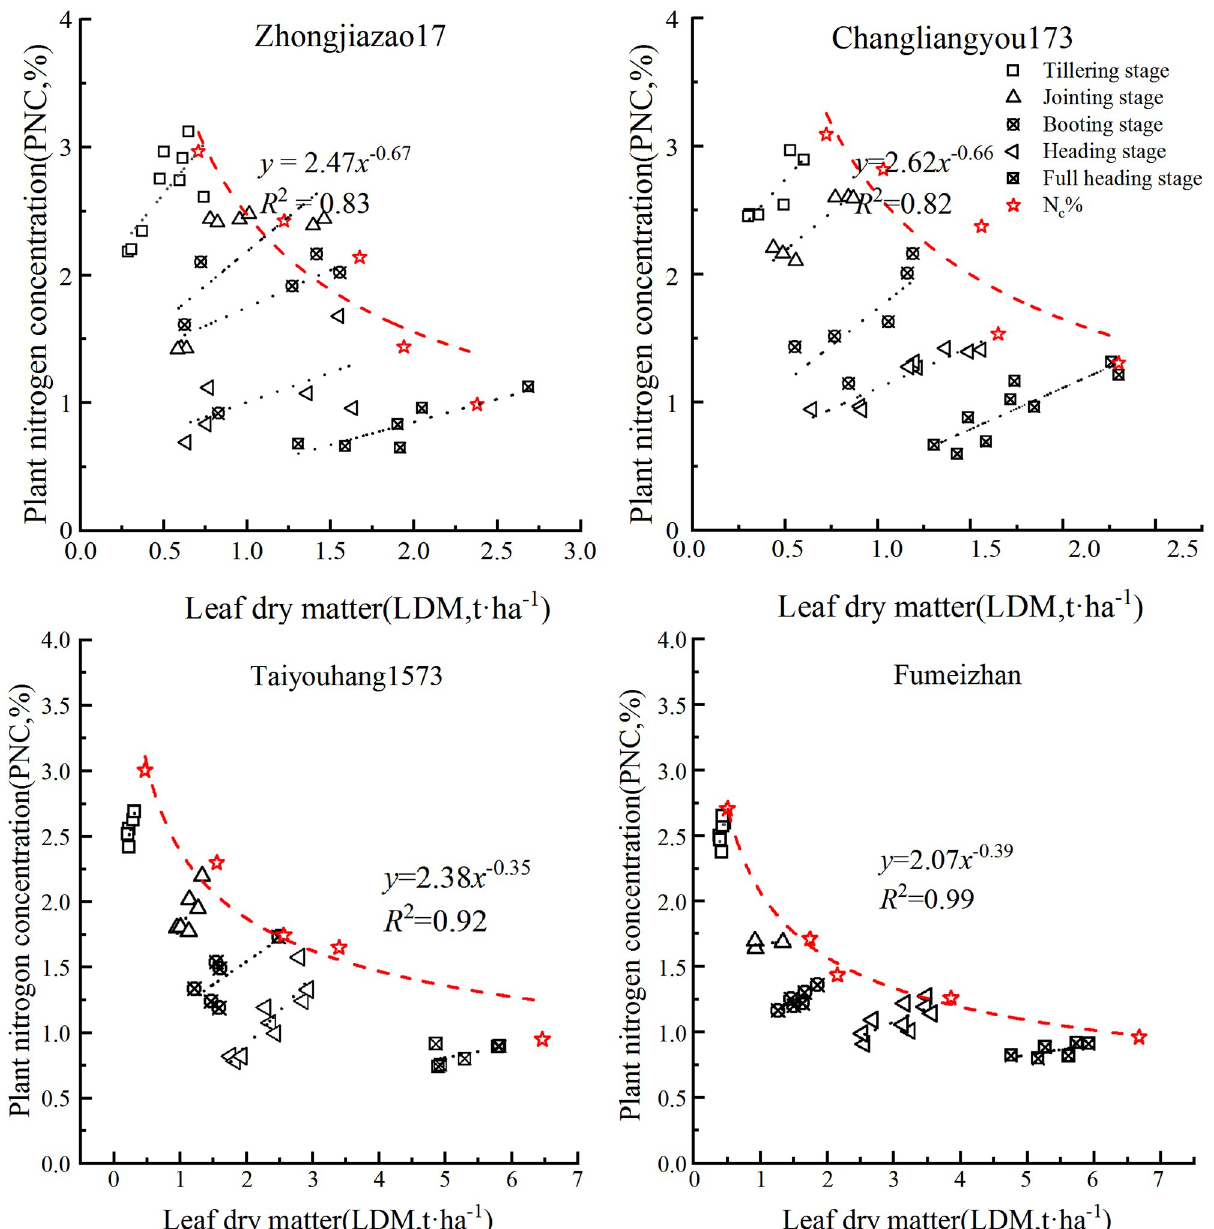
Fig 2. Critical nitrogen concentration dilution curve of rice based on leaf dry matter in 2020. stage. As for early rice: N0: 0.54–0.69, N75: 0.73–1.05, N150: 1.02–1.38, N225: 1.17–1.63; late